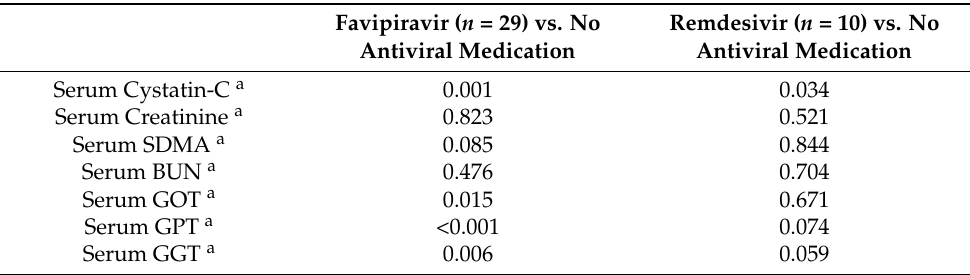
Table 6. Associations between serum renal and liver markers measured on baseline visit and antiviral